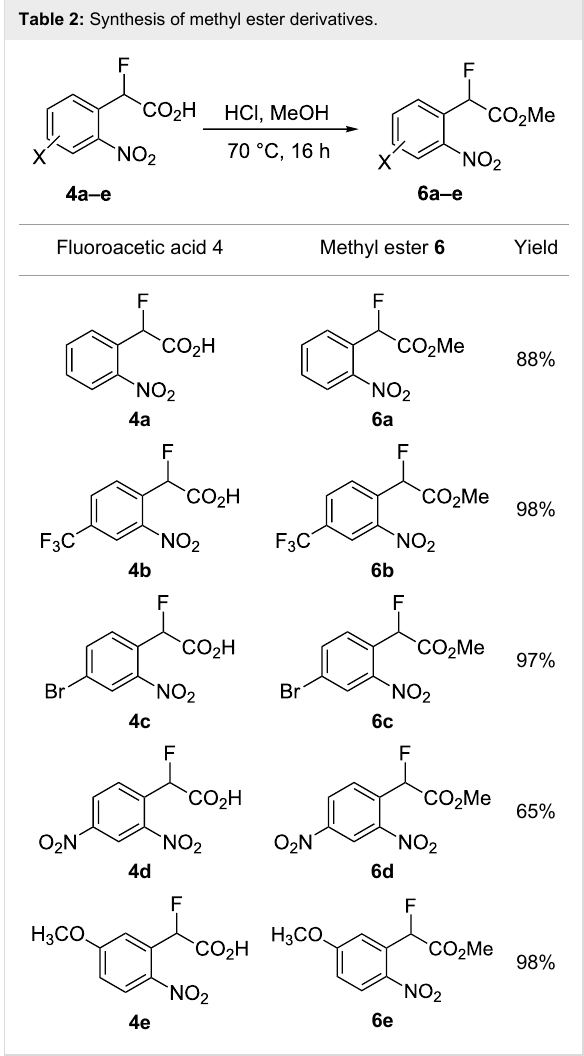
Table 2: Synthesis of methyl ester derivatives.